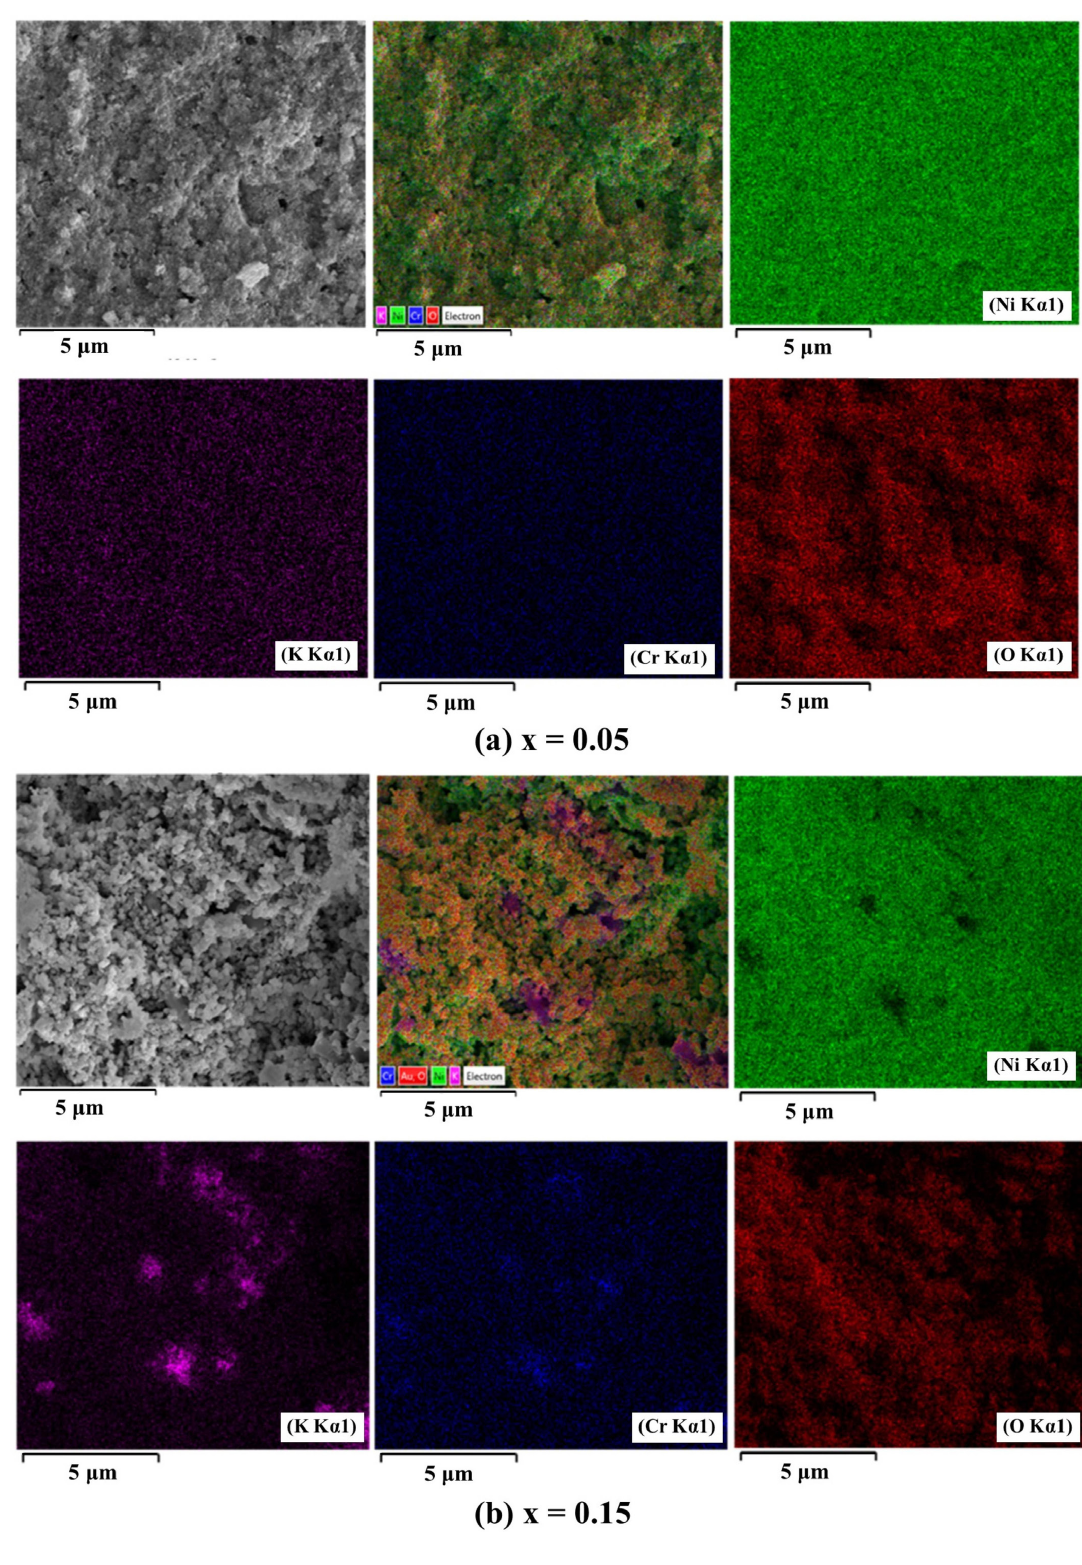
Figure 4. EDX element mapping images of the samples with (a) x = 0.05 and (b) x =